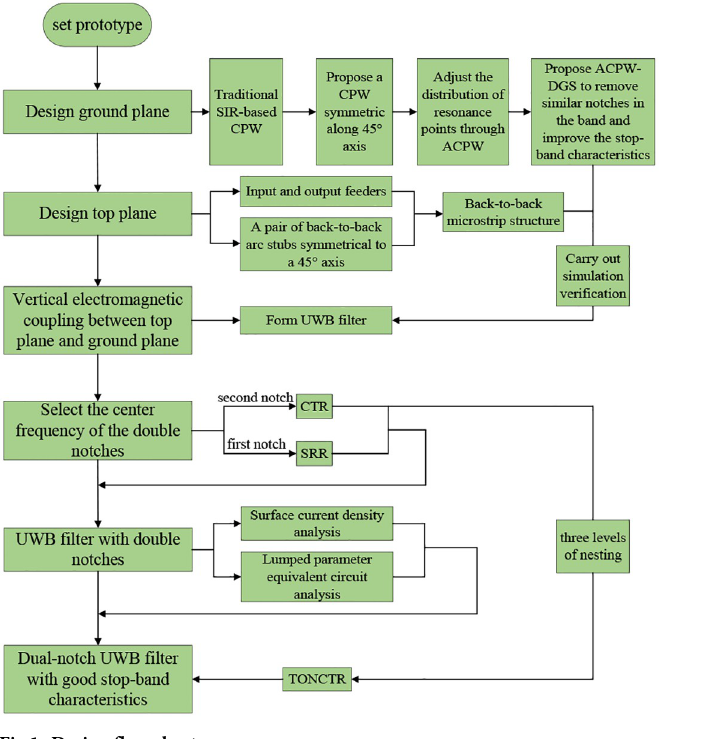
Fig 1. Design flow chart.